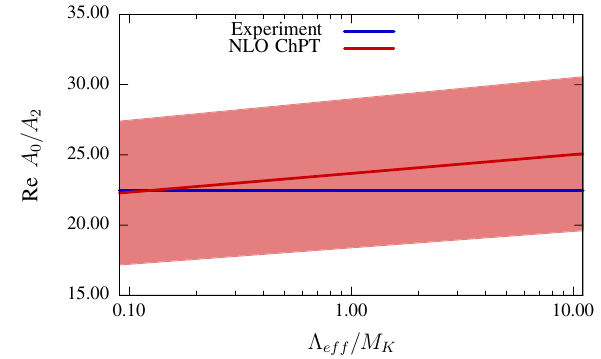
Fig. 7 NLO ChPT prediction (in red) for the ratio of K → ππ isospin amplitudes as a function of the NLO LEC, (cid:10) eff . We use the input of Fit 2 in Eq. (42). This prediction is valid for M π = M D = 0, and M K at its physical value. The shaded area represents the statistical error associated to the ratio of couplings — see Eq. (42). As a guideline, we also show the experimental value for the ratio of amplitudes (in